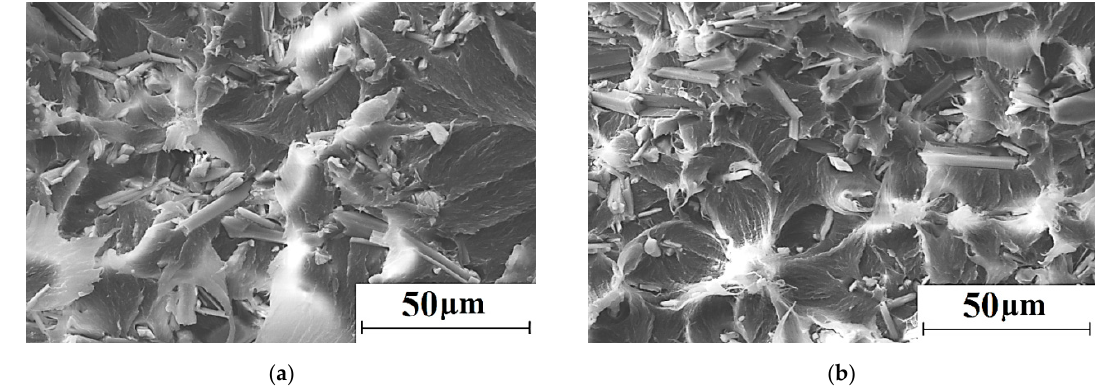
Figure 4. SEM micrographs of permolecular structure of the composites: UHMWPE + 23 wt. % wollastonite ( a ) and UHMWPE + 23 wt. % wollastonite + “KH-550” ( b )